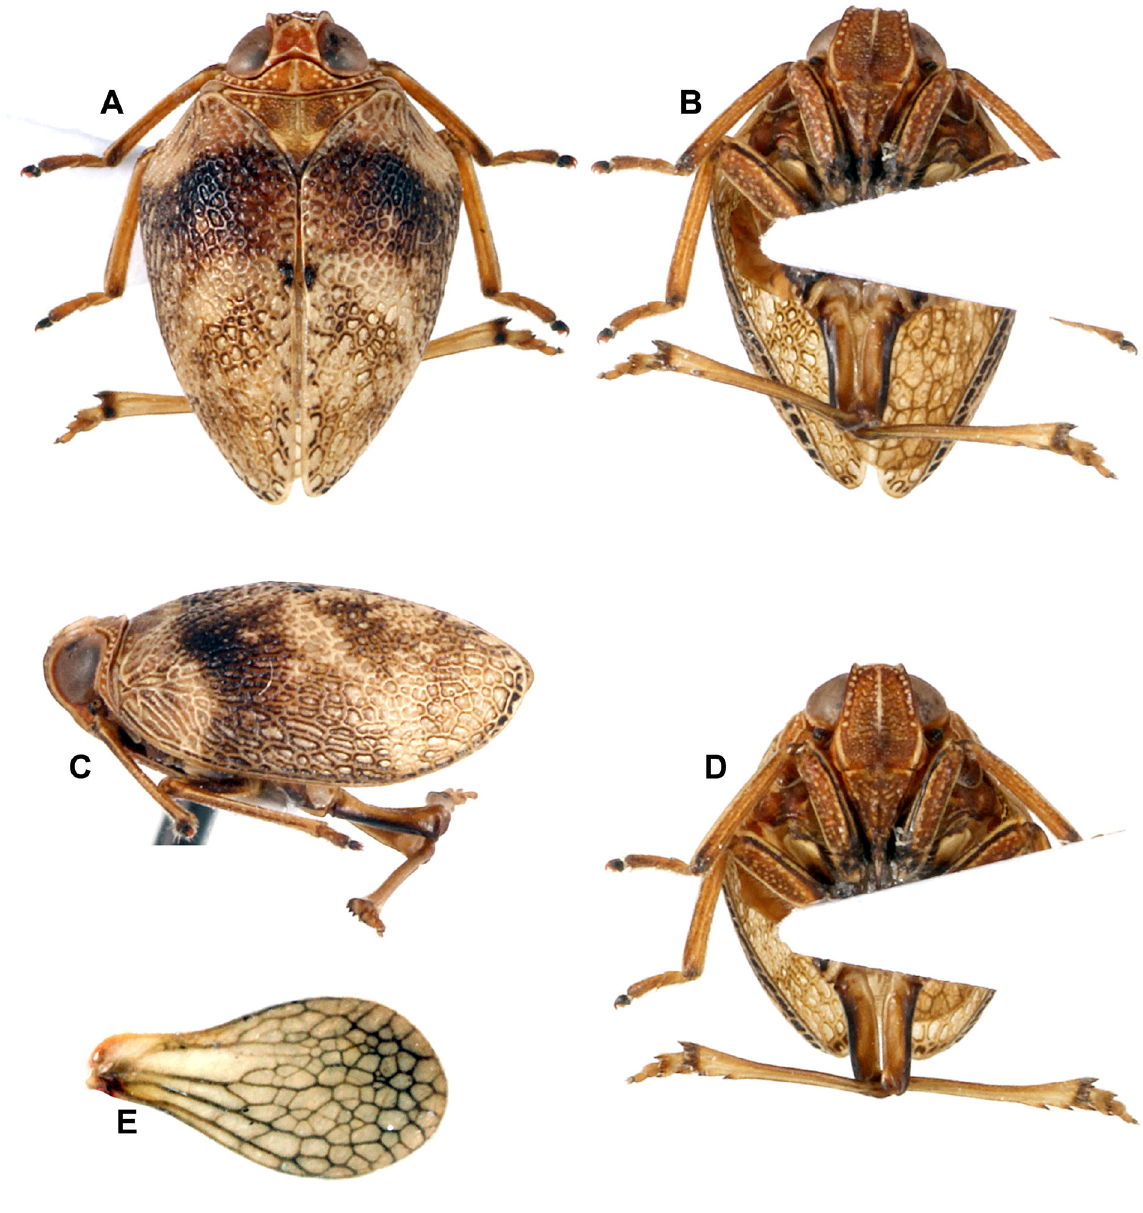
Fig. 1. Gergithoides gnezdilovi sp. nov., holotype, ♂, total length: 5.2 mm. A . Habitus, dorsal view. B . Habitus, ventral view. C . Habitus, lateral view. D . Habitus, normal view of frons. E . Right hind